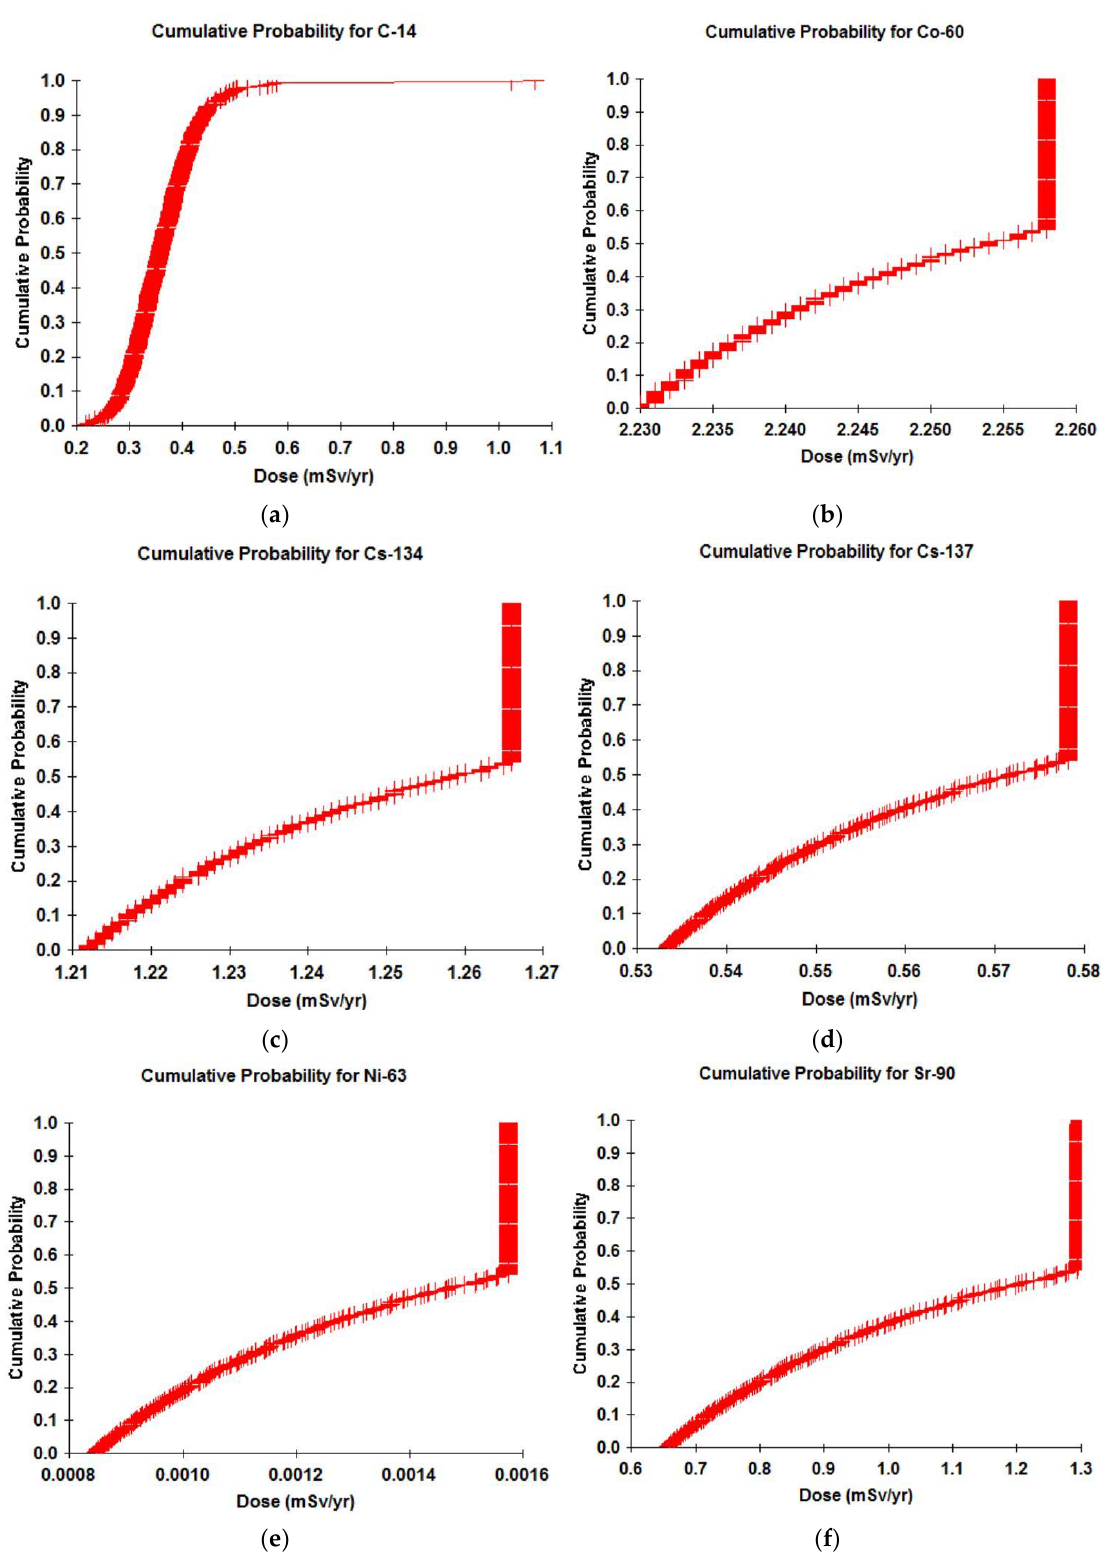
Figure 5. Cumulative probability and dose of each radionuclide: ( a ) C-14, ( b ) Co-60, ( c ) Cs-134, ( d ) Cs-137, ( e ) Ni-63, and ( f ) Sr-90. ( d ) Cs-137, ( e ) Ni-63, and ( f )